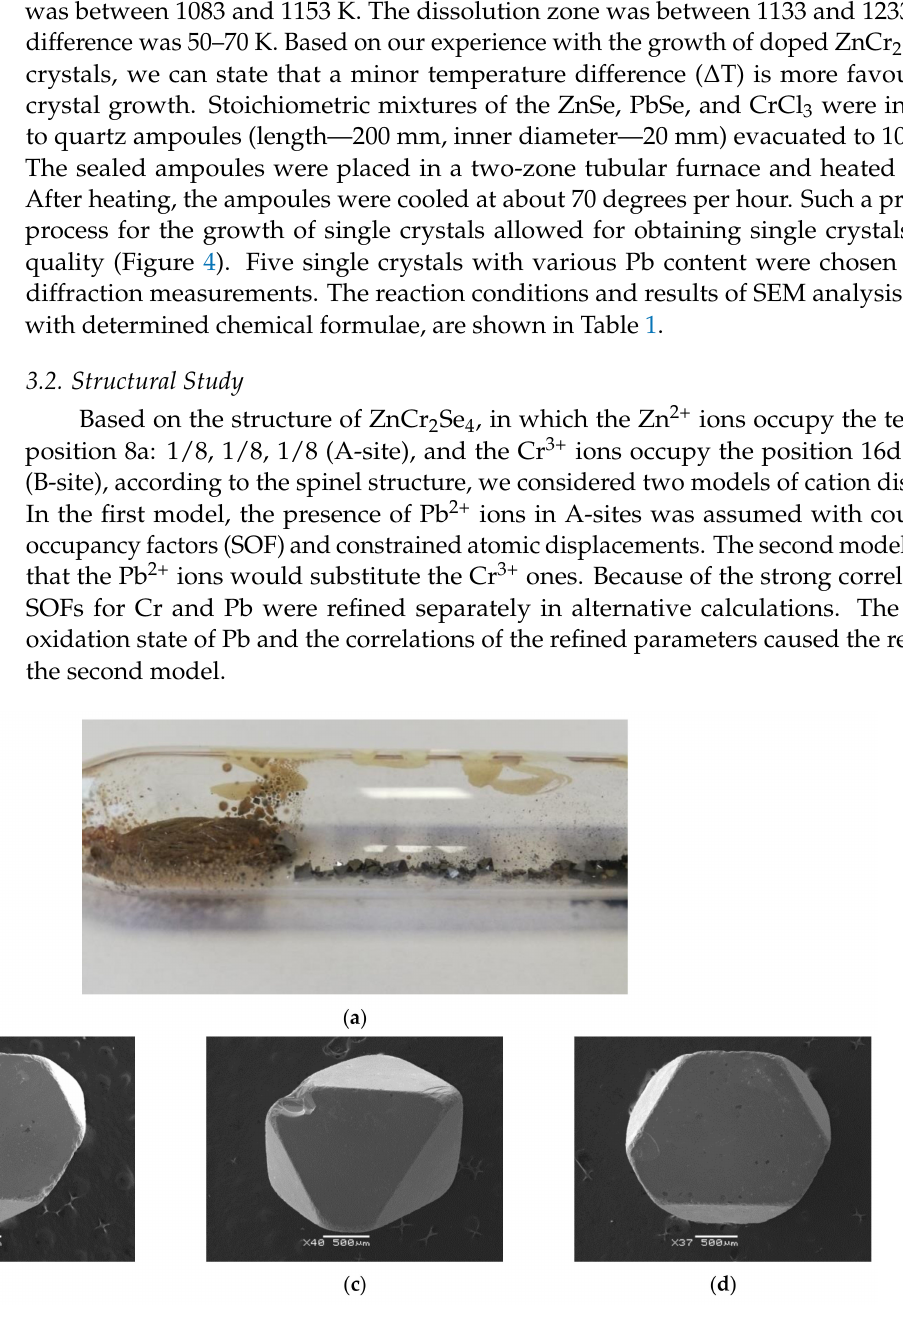
Figure 4. ( a ) A part of quartz ampoule with obtained ZnCr 2 Se 4 :Pb single crystals. Examples of sin- gle crystals obtained in the ZnCr 2 Se 4 :Pb system: ( b ) Zn 0.94 Pb 0.06 Cr 2 Se 4 , ( c ) Zn 0.92 Pb 0.09 Cr 2 Se 4 , ( d ) Zn 0.88 Pb 0.12 Cr 2 Se 4.